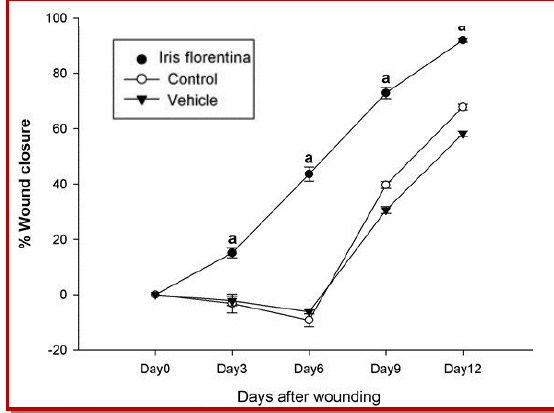
Figure 2: Wound closure rates in the control, IF treated, and vehicle-treated groups. Each point represents mean ± SD of the wounds of each group. The wound closure rate had sig- nificantly increased in IF treated group compared to the con- trol and vehicle-treated groups